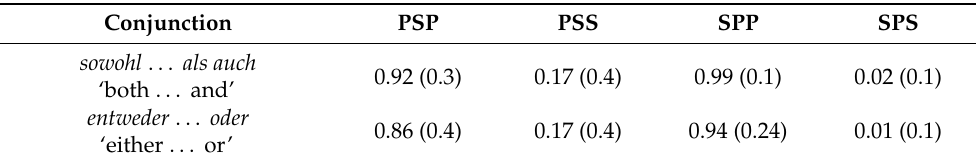
Table 12. Proportions of end-of-sentence acceptances (SDs in parentheses) per condition, Experiment 3 (S = singular, P =